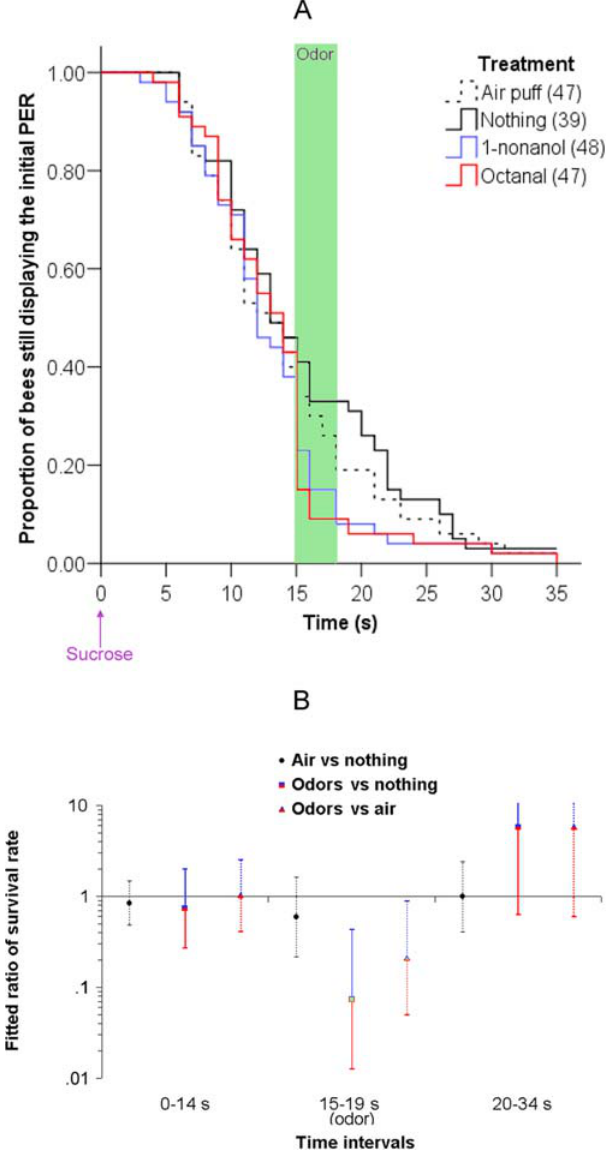
Figure 1. Olfactory interference: time course of the PER (A) and fitted ratio of survival rate (B). (A) Proportion of bees which are still displaying the initial PER as a function of the time after the onset of sucrose feeding (which started at 0 s). There is one curve for each of the four experimental groups: animals presented with an air puff, with no treatment (control group), with 1-nonanol or with octanal. The air puff or the odors were delivered 15 s after the onset of the sucrose feeding and lasted 4 s; this is indicated by the green area on the plot. Values in parenthesis are the number of animals used in each group. In subsequent figures, the odors are presented pooled because they never differed significantly. (B) Same data as in A, displayed in three sections: before odor onset (0–14 s), during odor presentation to one second after (15–19 s) and after the odor (20–34 s). For each of these time periods, Cox regression provided three ratios of the PER survival rates. Within each group, the PER survival rate is the proportion of bees that did not stop displaying a PER during a given time period. The Cox regression estimates fitted ratios of these PER survival rates. The ratios that are represented are (survival in the air-treated group)/(survival in the control group), (survival in the odor-treated groups)/(survival in the control group), and (survival in the odor-treated groups)/(survival in the air-treated group). A 95% confidence interval is determined for each ratio, illustrated by the error bars. The ratios odor/air and